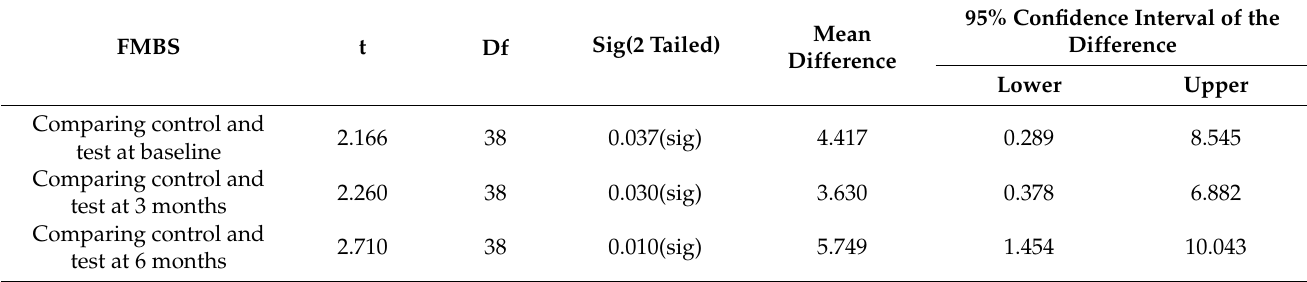
Table 3. Independent t -test for bleeding scores between Control and Test groups.